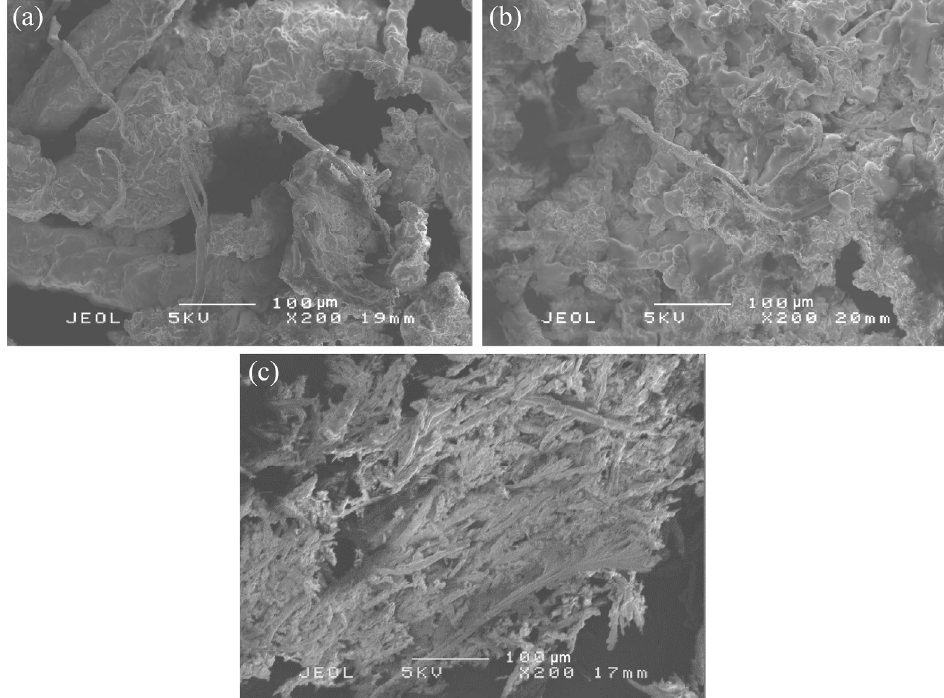
Fig. 11 SEM images of wear particles: (a) composite 15 SF when the Amontons’ law is valid (contact pressure of 0.20 MPa), (b) composite 15 SF when the Amontons’ law is not valid (contact pressure of 0.24 MPa), and (c) composite 20 SF+silica at a contact pressure of 0.80